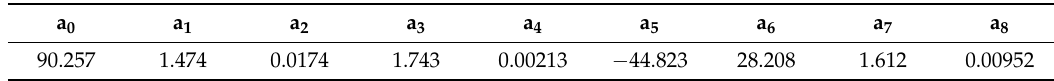
Table 6. Regression coefficients for converting narrowband irradiance to OLR.